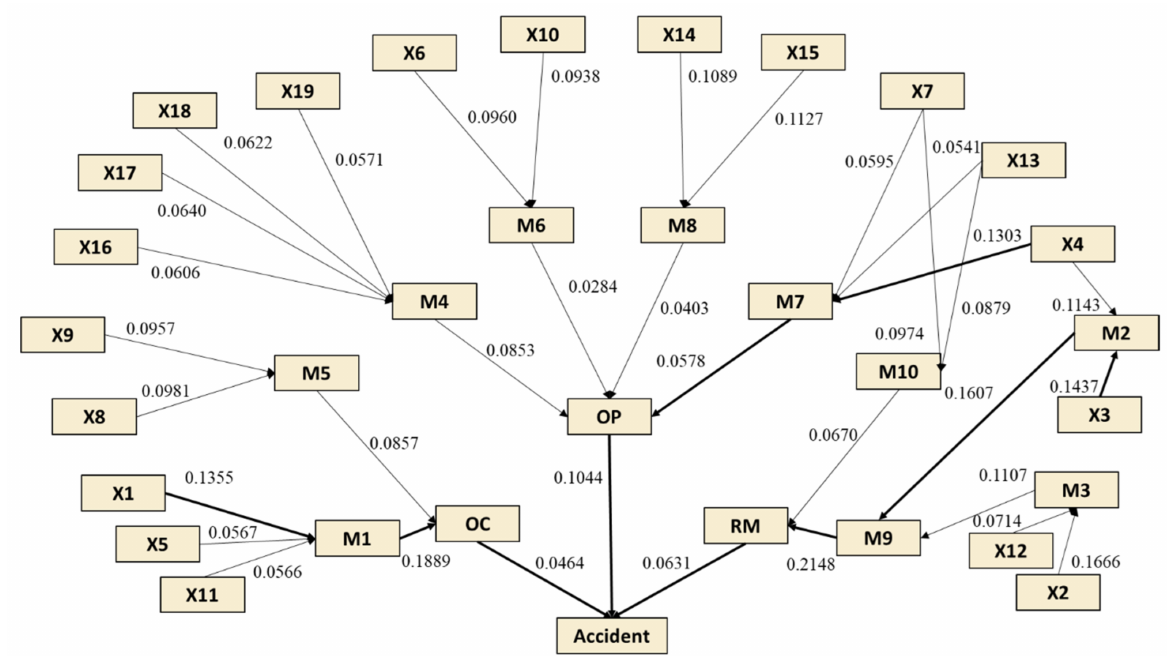
Figure 11. Degree of dependence among risks in different propagation